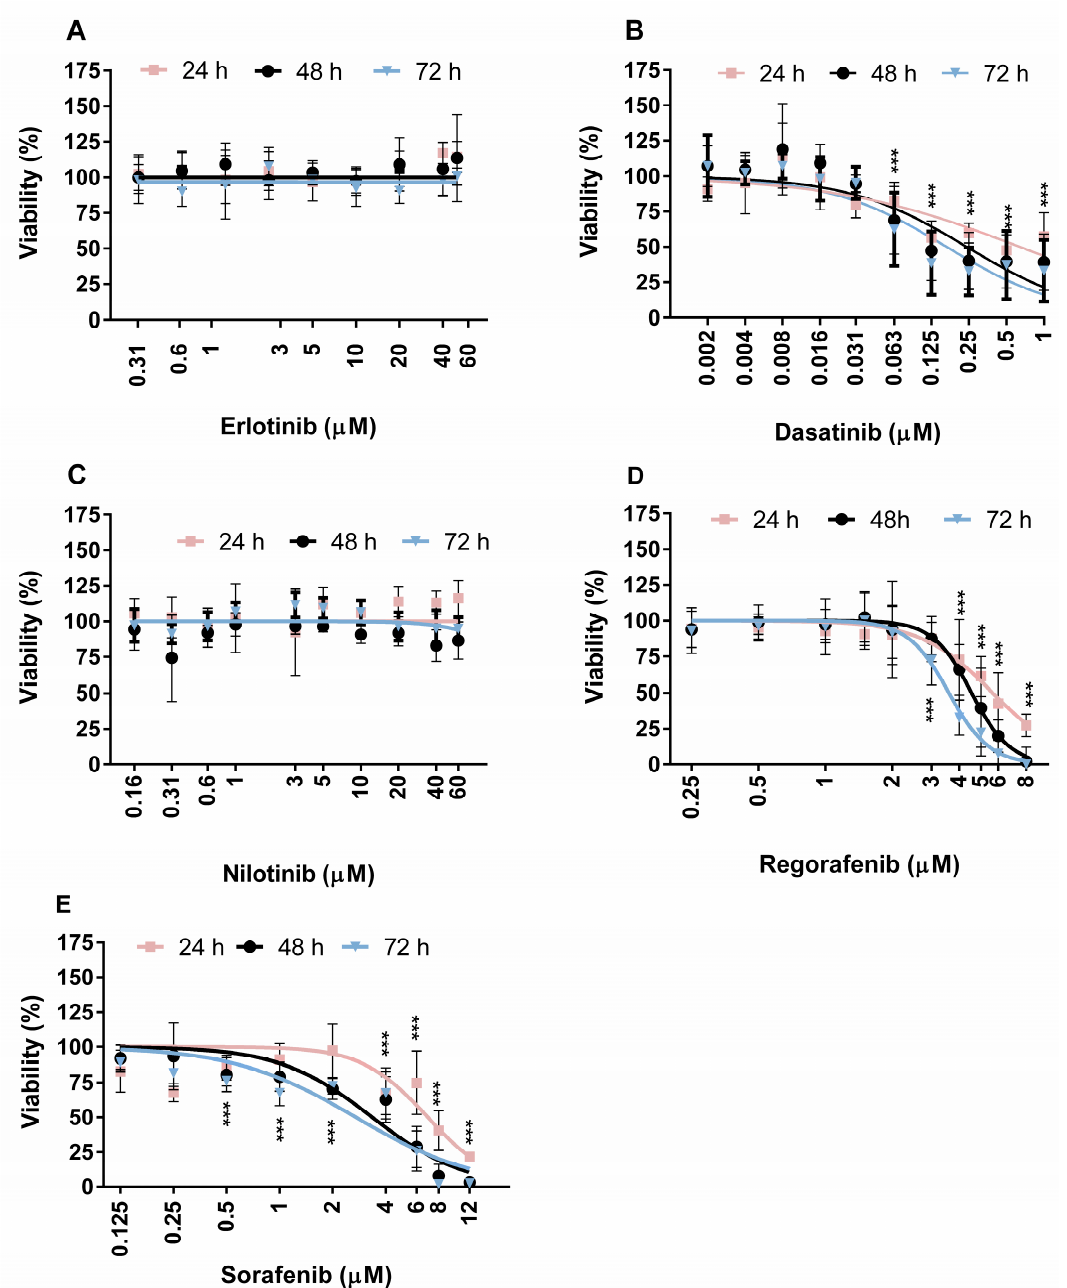
Figure 1. Effect of TKIs on the viability of zebrafish liver cells (ZFL): ( A ) erlotinib (ERL), ( B ) dasatinib (DAS), ( C ) nilotinib (NIL), ( D ) regorafenib (REG), ( E ) sorafenib (SOR). Values on graphs are presented using linear regression on an antilog numbering format of x axis. The viability of cells was determined with the MTS assay with three independent experiments of five replicates each. *** ( p < 0.001). Similar effects were induced by SOR, which blocks similar kinases to REG [29]. A sig- nificant change in cell viability was observed after 48 h exposure of Huh-7 and HepG2 cells to 2 µ M and 5 µ M SOR, respectively [39]. Furthermore, IC 50 values of 10.04 µ M